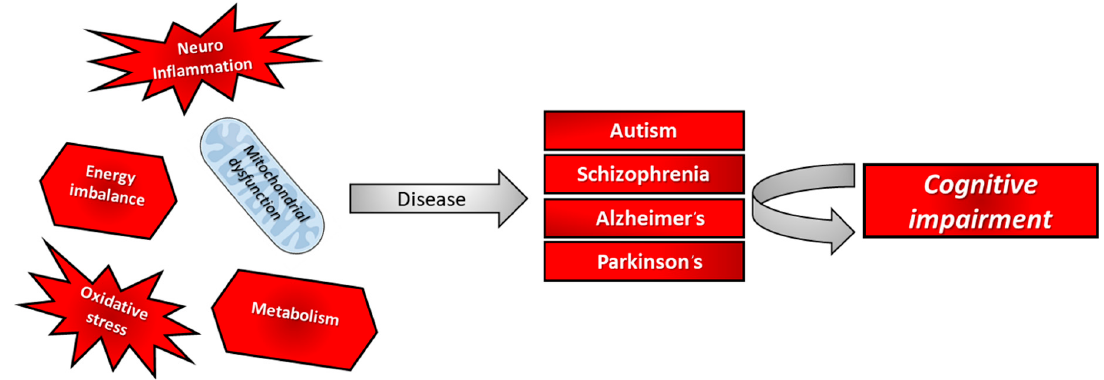
Figure 1. Cognitive impairment causes in some neurological diseases.